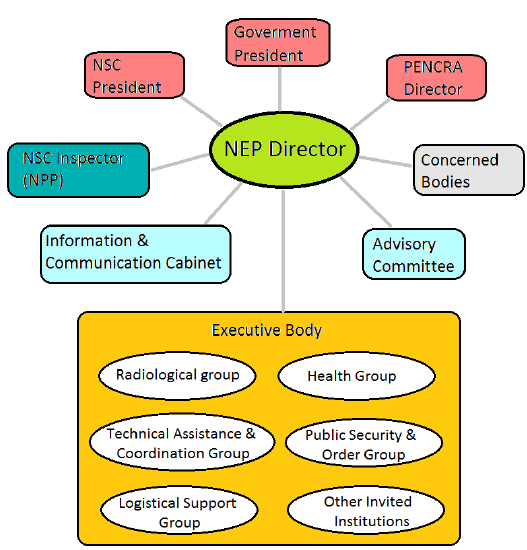
Figure 2. Sketch of the structure of the